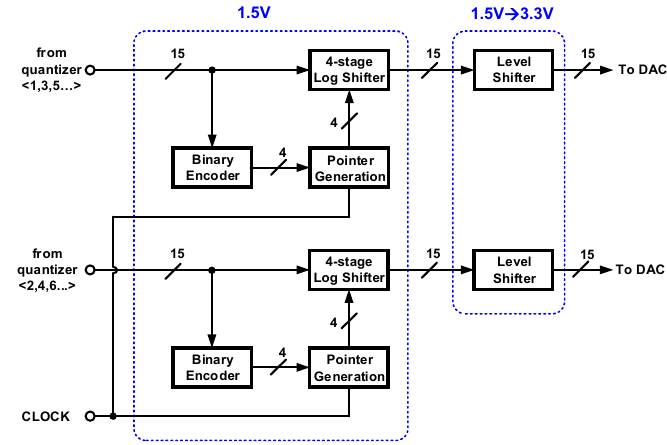
Figure 9. Block diagram of the two sets of dynamic element matching (DEM) with logarithmic shifter.